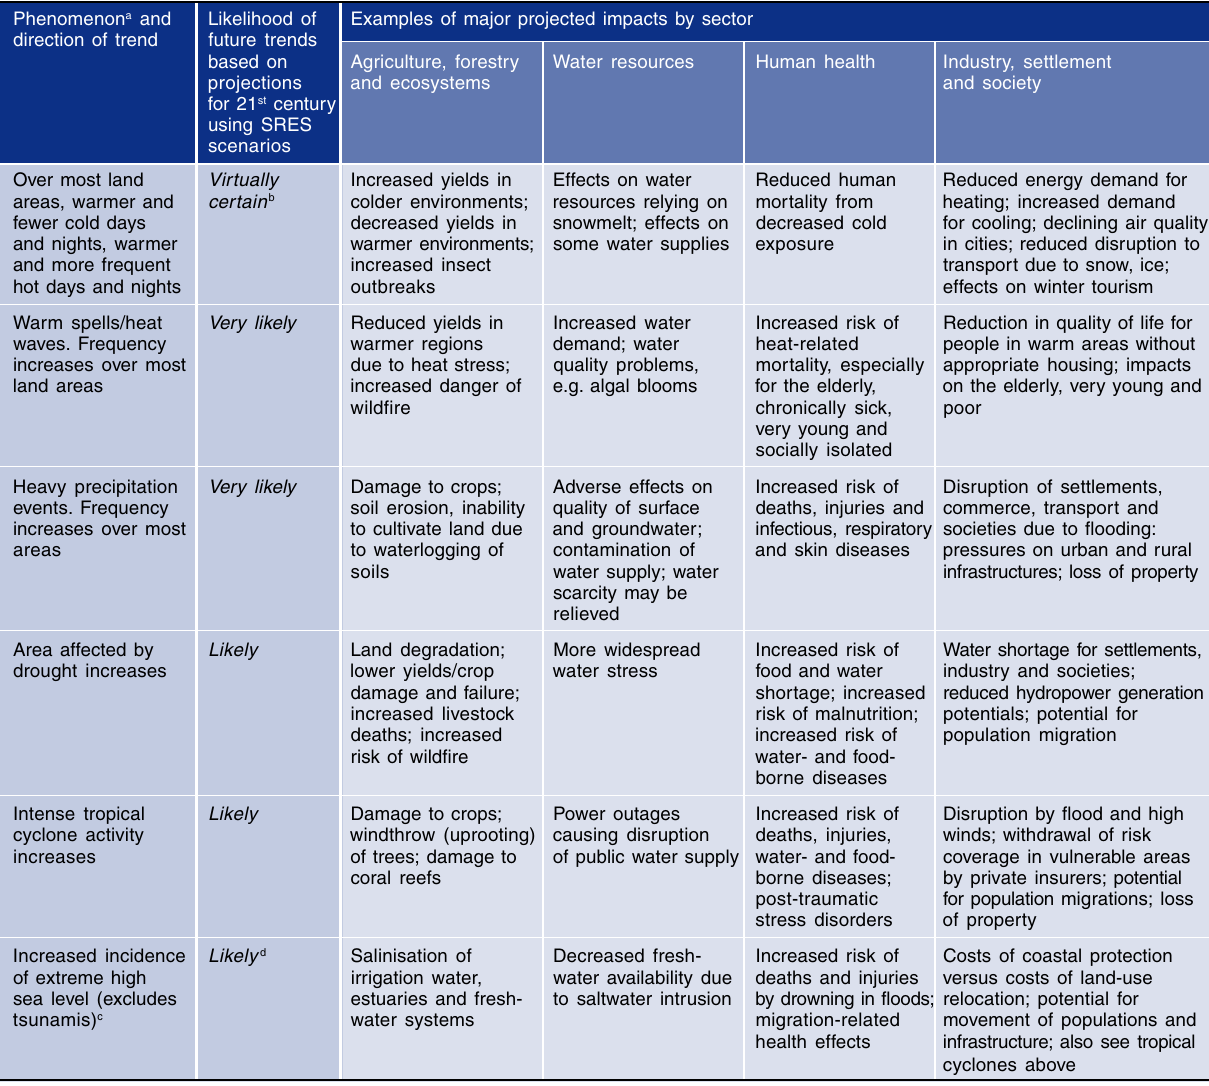
Table SPM.3. Examples of possible impacts of climate change due to changes in extreme weather and climate events, based on projections to the mid- to late 21 st century. These do not take into account any changes or developments in adaptive capacity.